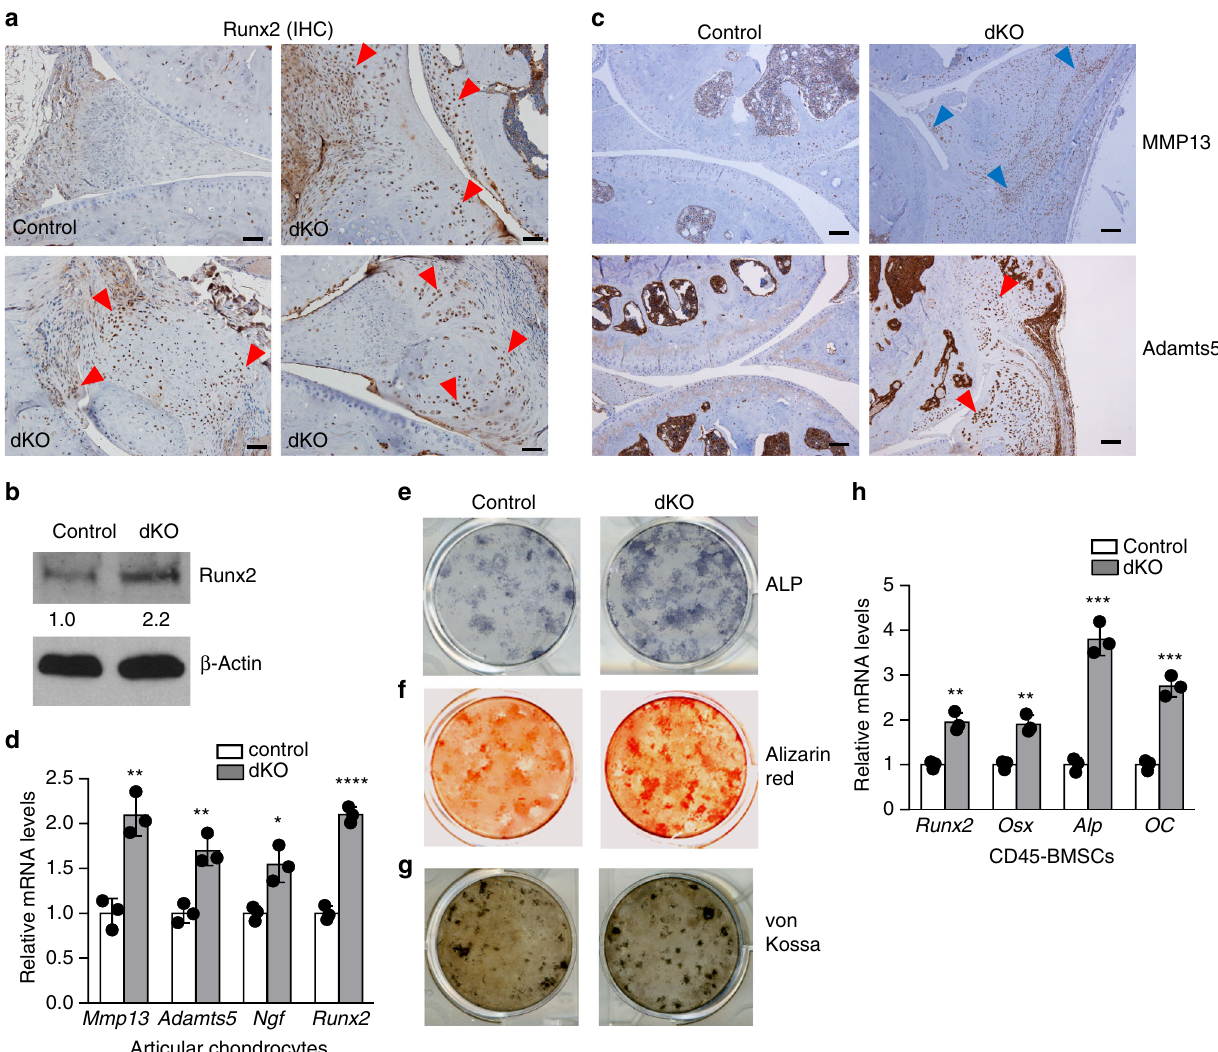
Fig. 3 De fi ciency of miR-204 / -211 upregulates Runx2, cartilage-catabolic enzymes and osteogenic markers. a IHC results show enhanced Runx2 expression in the synovium, articular cartilage (AC), and meniscus of knee joints of dKO mice. Red arrowheads, Runx2-positive cells. Scale bar, 50 μ m. b Western blot analysis shows Runx2 accumulation in CD45 − BMSCs isolated from dKO mice. The numbers below the blot indicate the relative protein levels of Runx2 (normalized to β -actin) in each group compared to the control. n = 3. c IHC results of MMP13 and Adamts5 in control and dKO mice. Arrowheads, IHC- positive cells. Scale bar, 100 μ m. d qRT-PCR analysis of Mmp13 , Adamts5 , nerve growth factor ( NGF ), and Runx2 expression in articular chondrocytes from control or dKO mice. Unpaired Student ’ s t test. n = 3. Data are shown as the mean ± s.d. e − g Alkaline phosphatase (ALP) staining ( e ), Alizarin red staining ( f ), and von Kossa staining ( g ) of BMSCs isolated from control or dKO mice. n = 3. h qRT-PCR analysis of Runx2 , Osterix ( Osx ), Alp and Osteocalcin ( OC